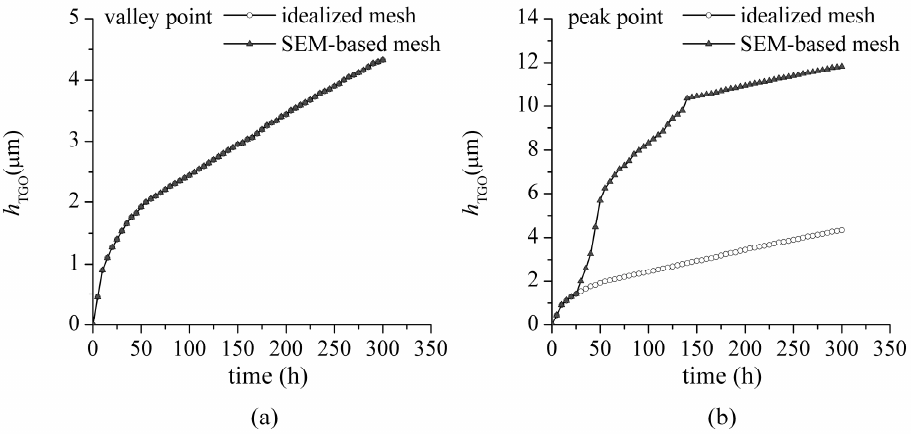
Figure 5. Evolutions of TGO thickness in ( a ) the valley and ( b ) peak regions of both meshes.